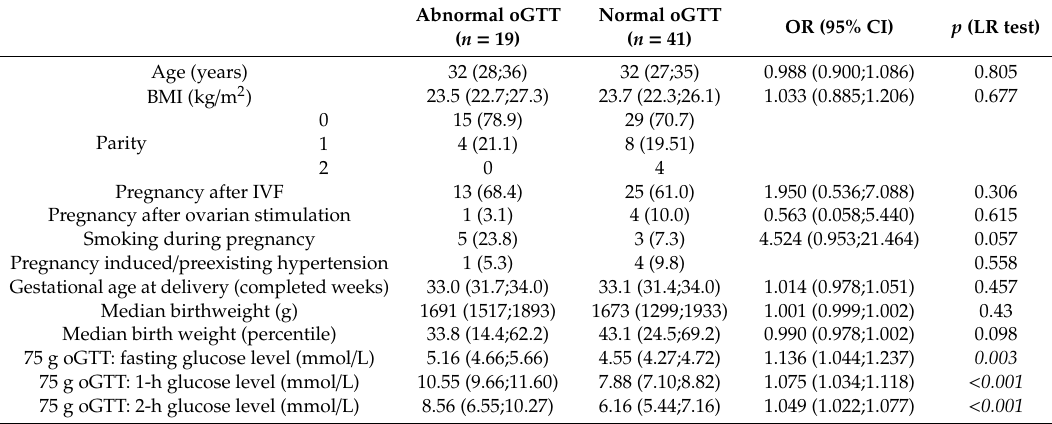
Table 2. Triplet pregnancies with and without GDM, defined as an abnormal 75 g, 2-h